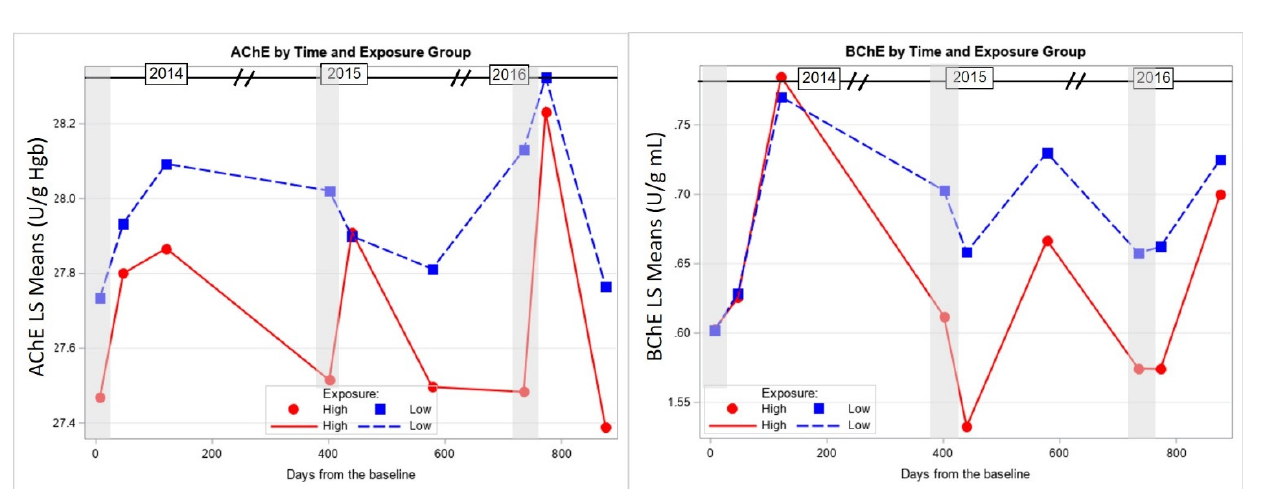
- a Significantly different from baseline; b significantly different from the previous timepoint; c significant difference between high and low CPF exposure groups. tween high and low CPF exposure groups.